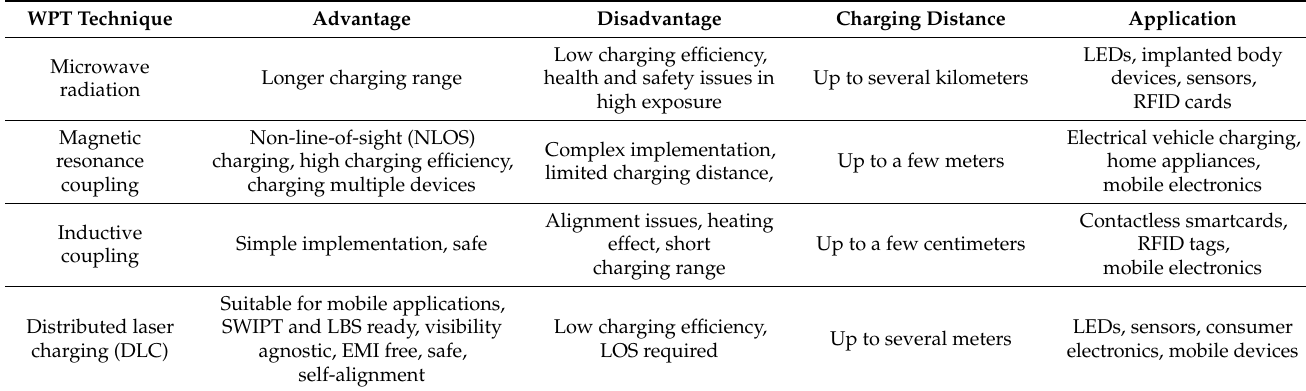
Table 4. A comparison of different WPT techniques